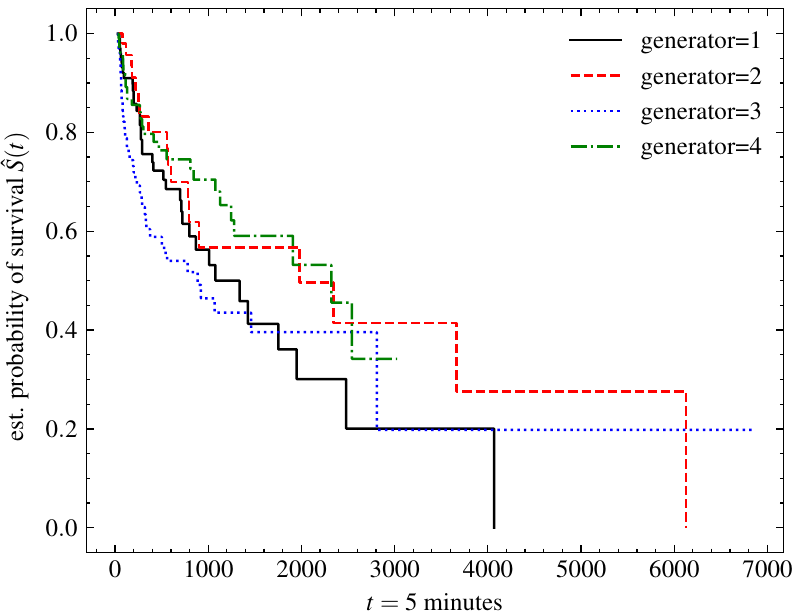
Figure 2. Kaplan–Meier model adjusted for each of the generators. The decay rate of the survival function of the adjusted model for each of the generators was similar, indicating the correlated behavior of the health of the generating